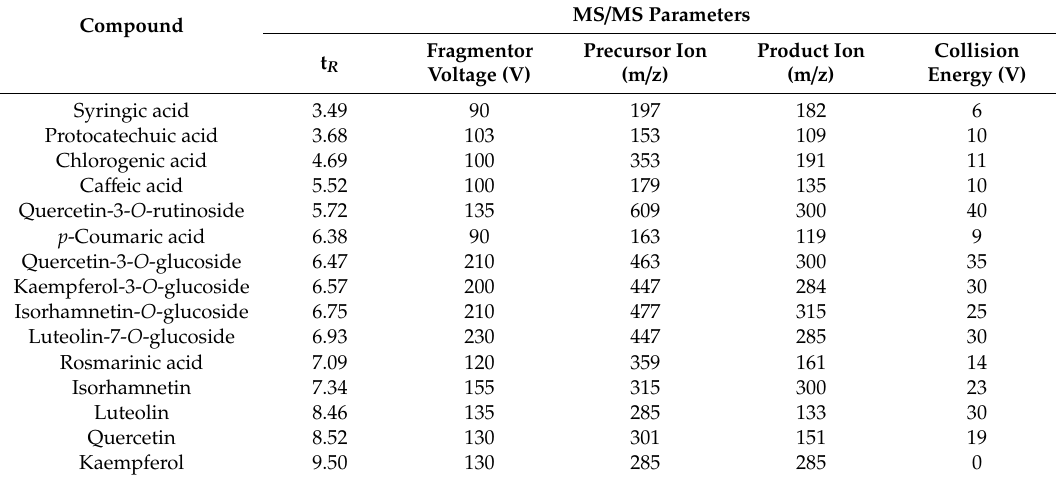
Table 8. LC-MS / MS parameters for standard phenolic